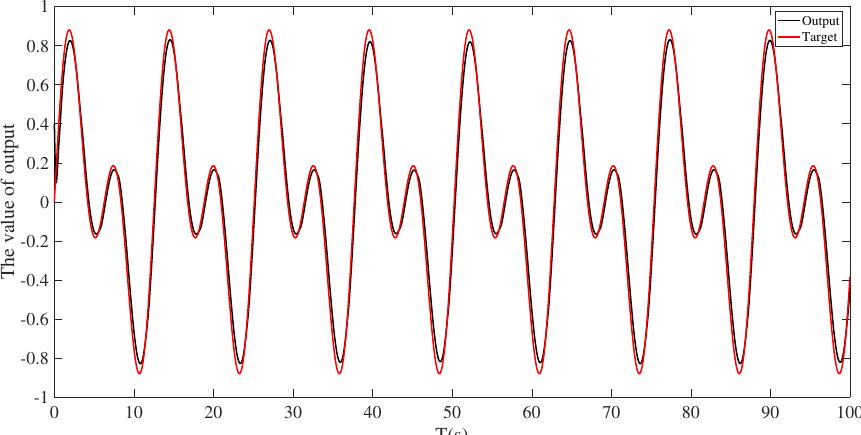
Figure 14. Output and target curves in the case of a chemical cycle.